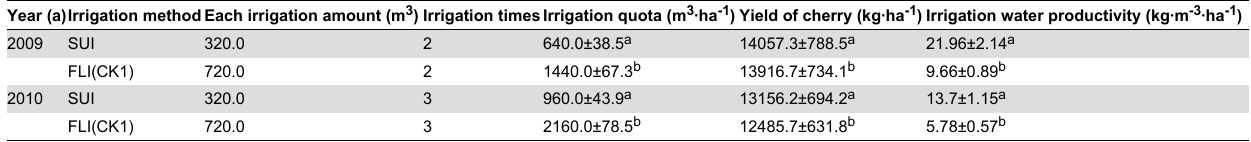
Table 4. Soil moisture content for the different SUI and FLI quotas.